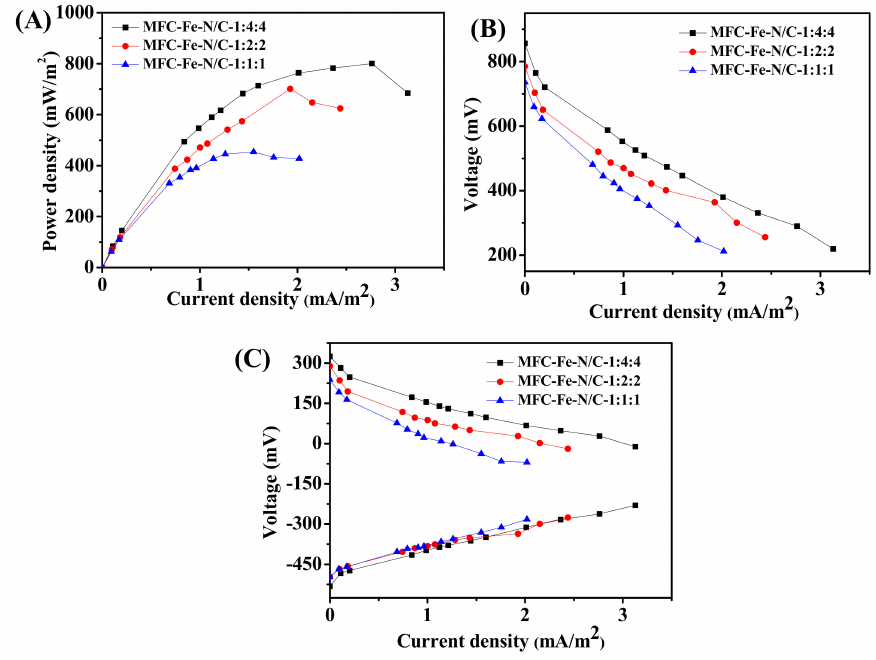
Figure 4. Electricity production performance of the microbial fuel cells (MFCs) using the catalysts with different Fe-doping contents: ( A ) power density curves; ( B ) polarization curves; and ( C ) the anode and cathode polarization